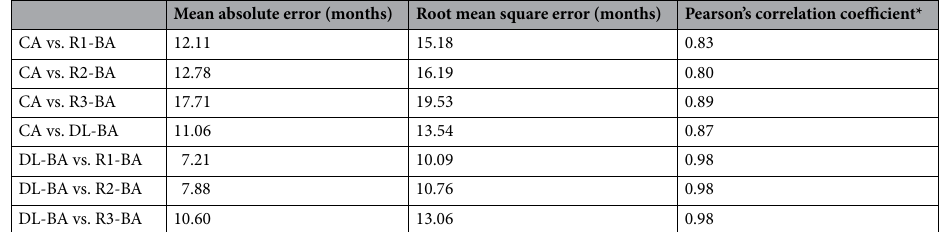
Table 1. Statistical analysis of DL-estimated and each reviewer-estimated BA, and chronological age. DL deep learning, CA chronological age, BA bone age, R reviewer. *All P < 0.025.